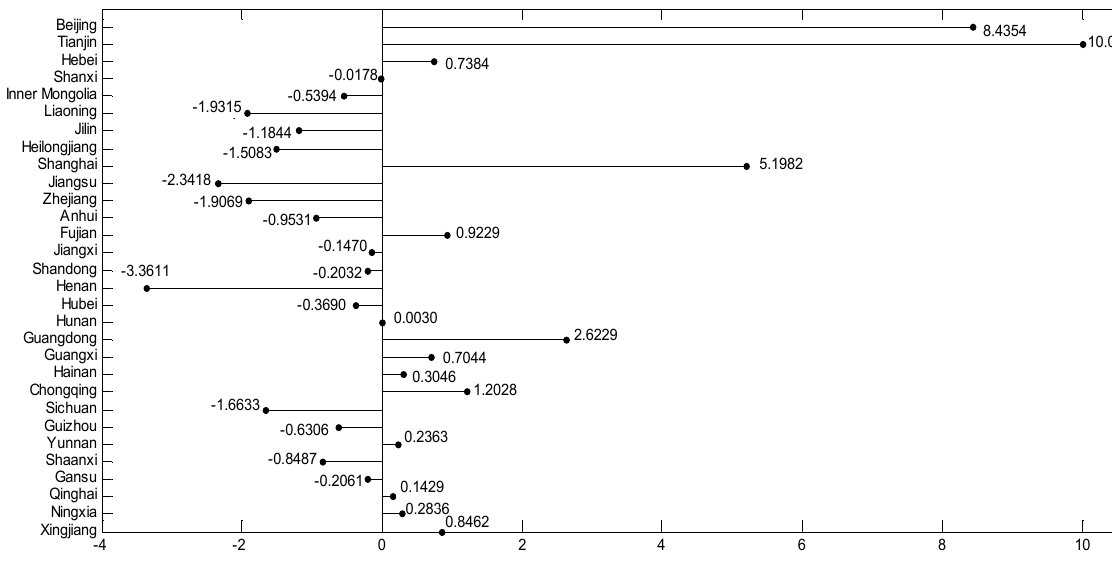
Figure 9. The contribution value of population